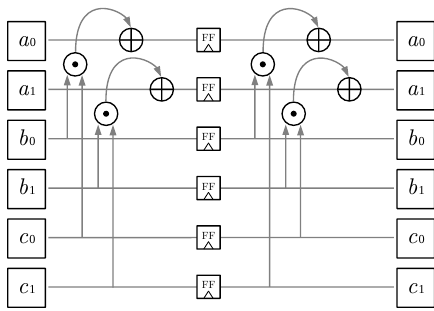
Figure 6: Masked and single-fault SIFA-protected Toffoli gate in